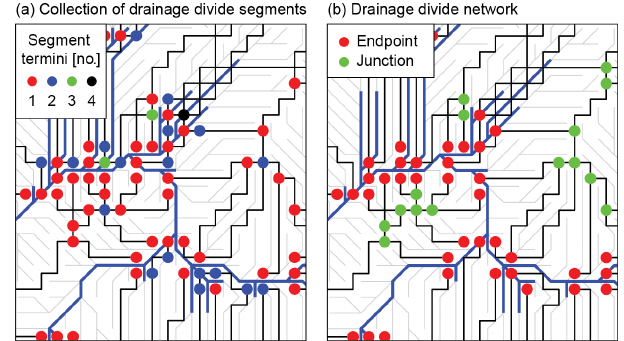
Figure 6. Transformation of a collection of drainage divide seg- ments (a) into a drainage divide network with endpoints and junc- tions (b) . Black lines are drainage divides, blue lines are streams, and flow directions are shown as light gray lines. Note that we used a minimum upstream area of only 10 pixels to define the stream network for illustration